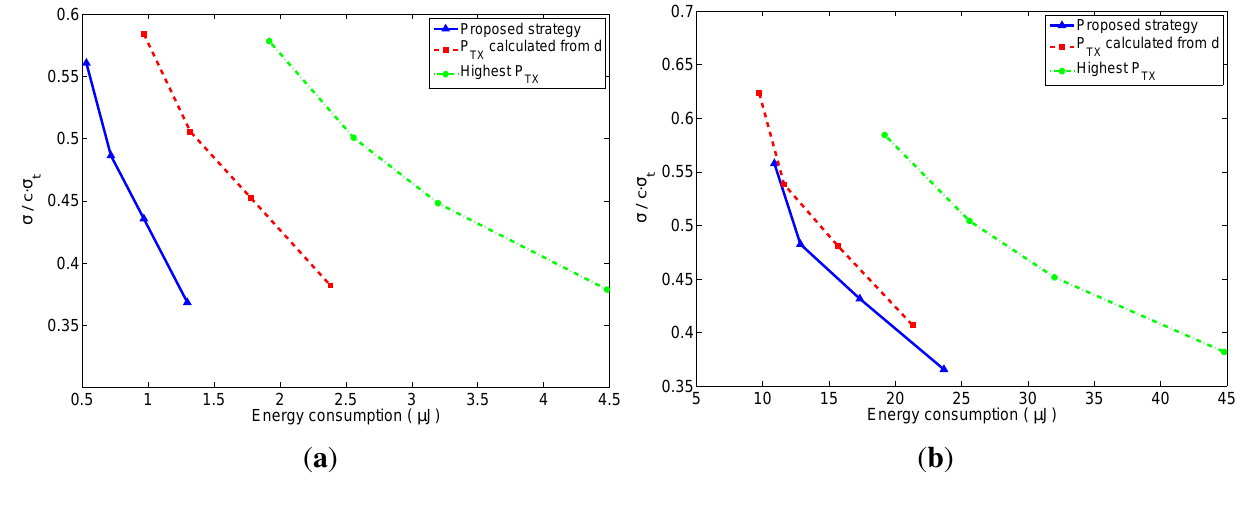
Figure 11. Relation between the average energy consumption per localization and the RSS-based distance estimation accuracy for the three